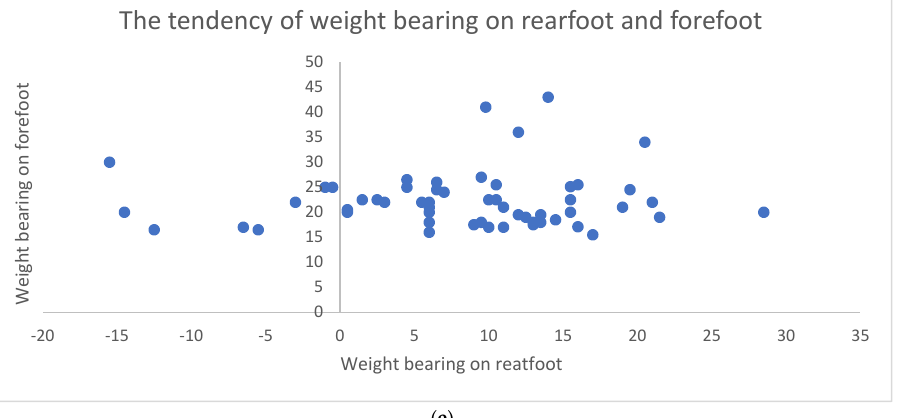
Figure 7. ( a ) The correlation of forefoot pressure (kPa) and weight (R = 0.13); ( b ) the correlation of rearfoot pressure (kPa) and weight (R = 0.16); ( c ) the correlation of forefoot pressure (kPa) and height (R = 0.16); ( d ) the correlation of rearfoot pressure (kPa) and height (R = 0.13); and ( e ) the tendency of weight bearing on rearfoot and forefoot (R =